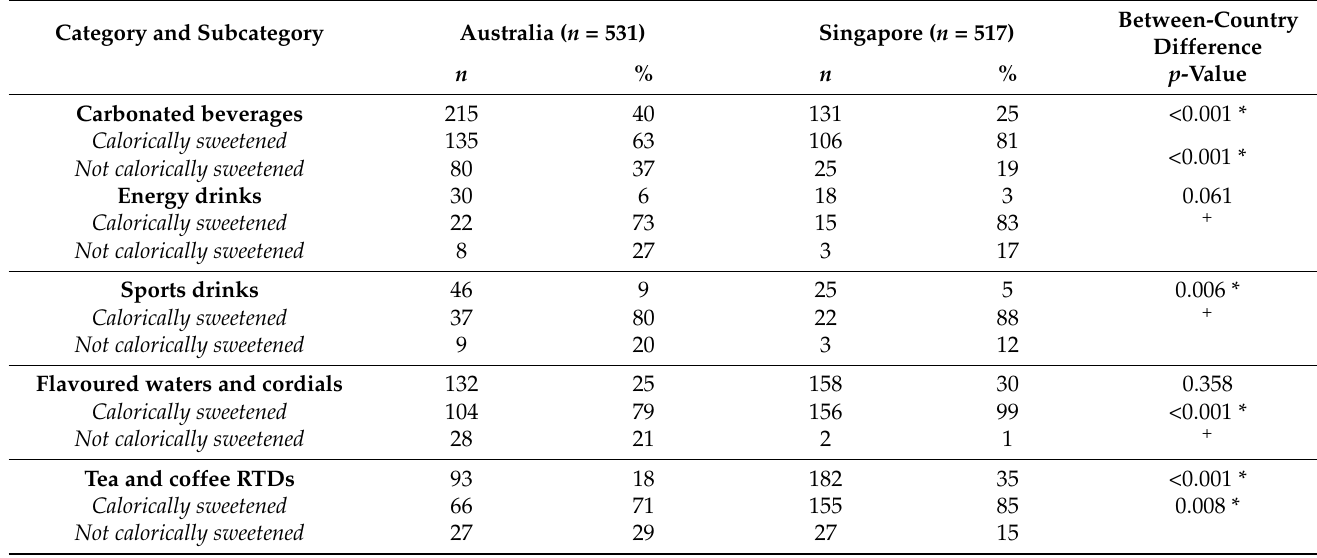
Table 2. Numbers and proportions of beverage products collected within each category and subcate- gory in Australia (2019) and Singapore